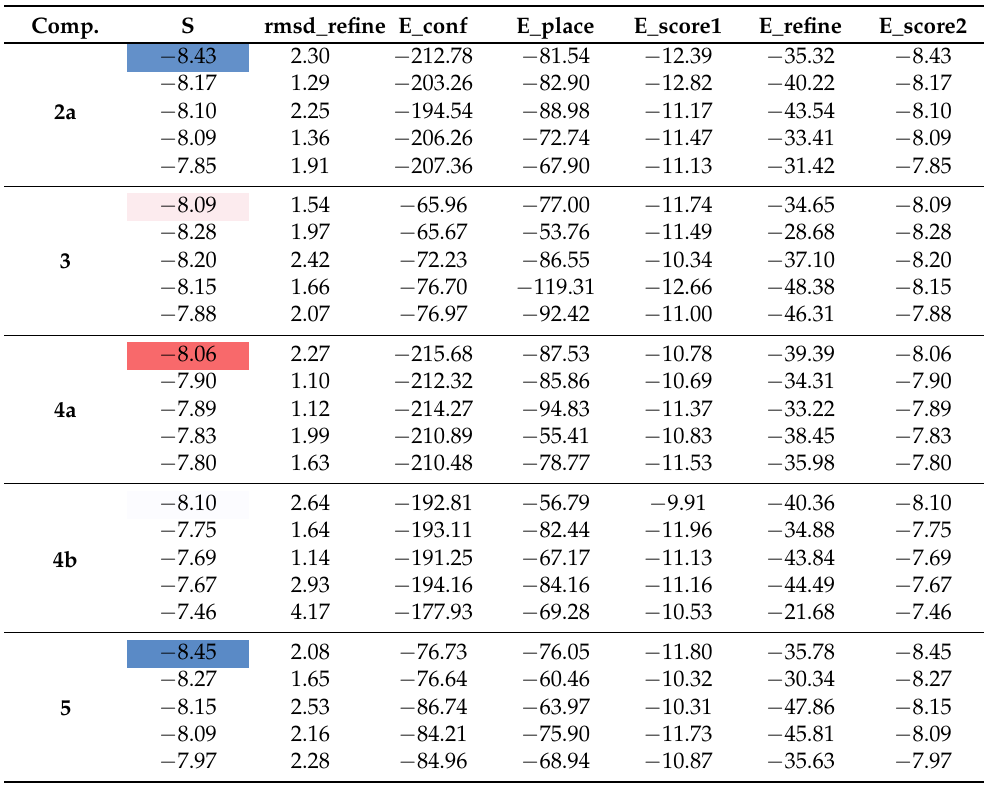
Table 3. Docking score and energies of all compounds with MCF-7 breast docking result of “ 3 KRR ”